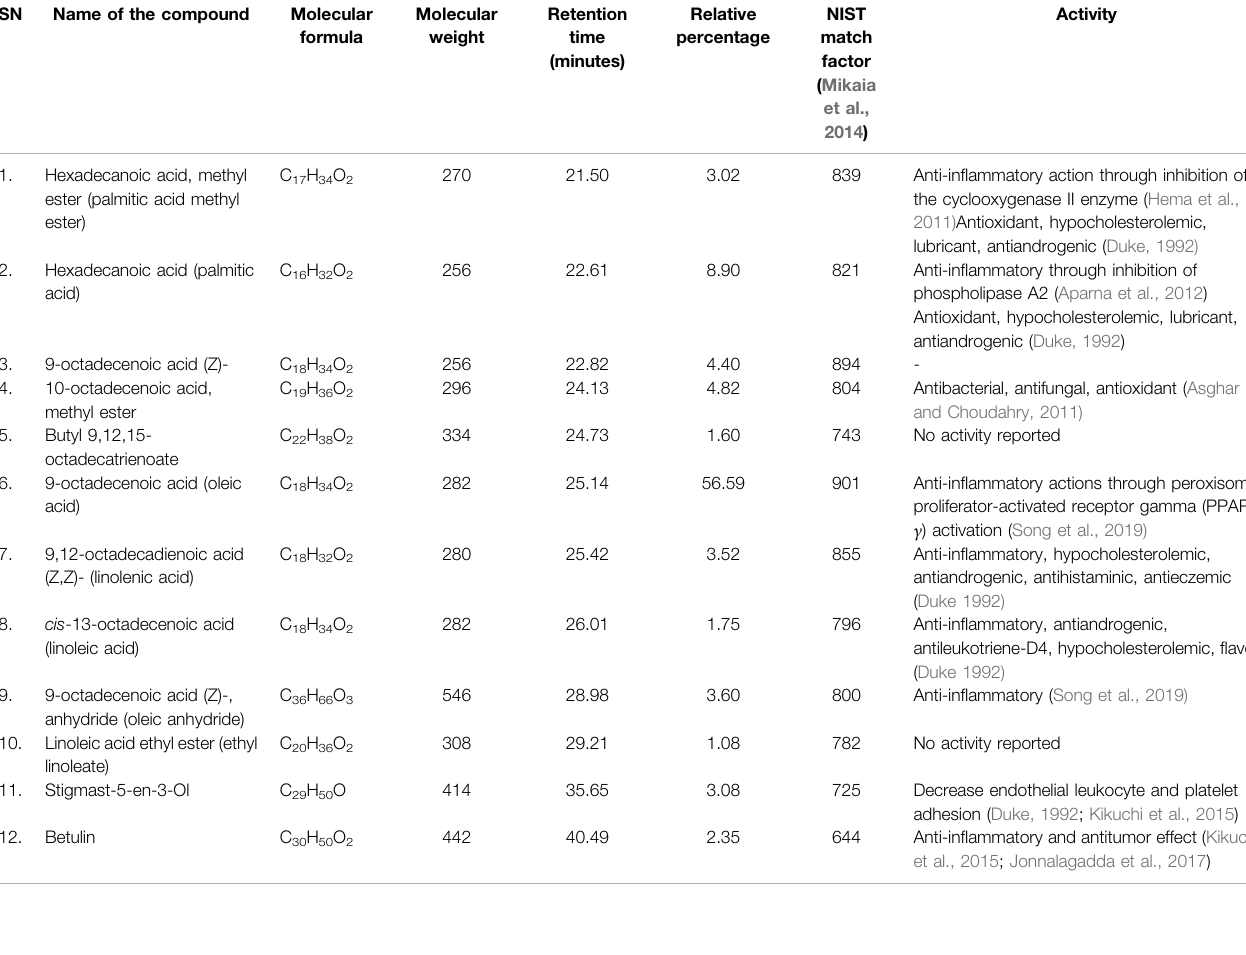
TABLE 2 | Components of Cucurbita pepo L. extract identi fi ed using gas chromatography and mass spectrometer (GC – MS) analysis. SN Name of the compound Molecular formula